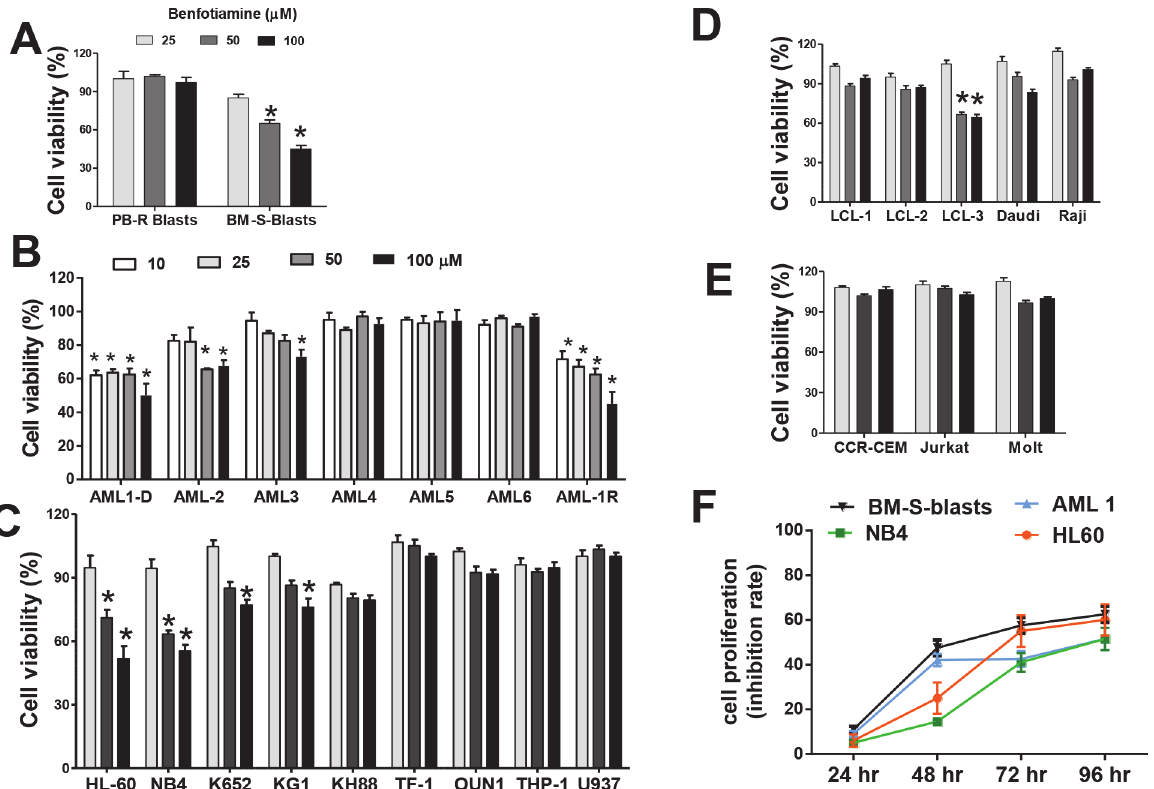
Fig 1. Effects of benfotiamine on the viability of leukemic cells. BM-S and PB-R leukemic blasts (A), primary leukemia cells from six patients with AML (B), myeloid leukemia cell lines (C), malignant B cell lines (D) and T cell leukemia (E) were left untreated or treated with the indicated doses of benfotiamine and cultured for 72 hours. Cell viability was assessed using an MTT assay. The error bars represent relative cell viability with respect to the untreated control cells and are the means (SEM) of three independent experiments. (F) Growth curves of leukemia cells exposed to 50 uM of benfotiamine and analyzed at multiple time points using a colorimetric MTT assay. The average data of three independent experiments are shown.